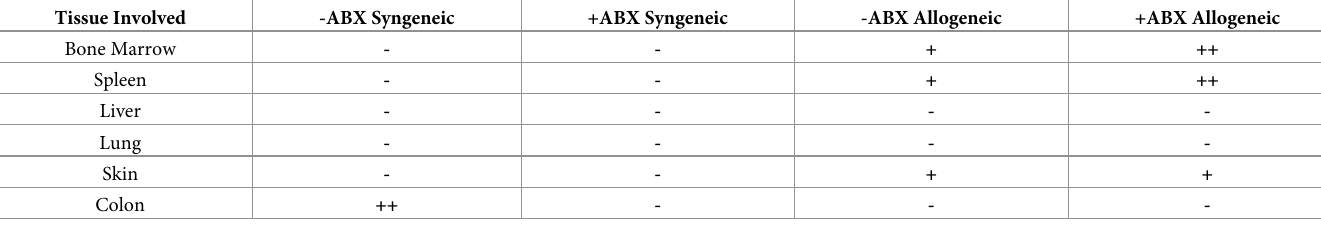
Inflammatory tissue damage in each tissue of the 4 groups is summarized based upon blinded histopathological analysis as described in the methods. Tissue with moderate (+), severe damage (++) or no discernable pathology (-) are